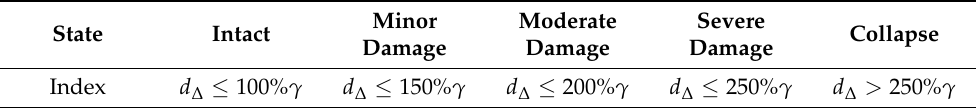
Table 3. Description of isolated bearing damage indexes (unit: